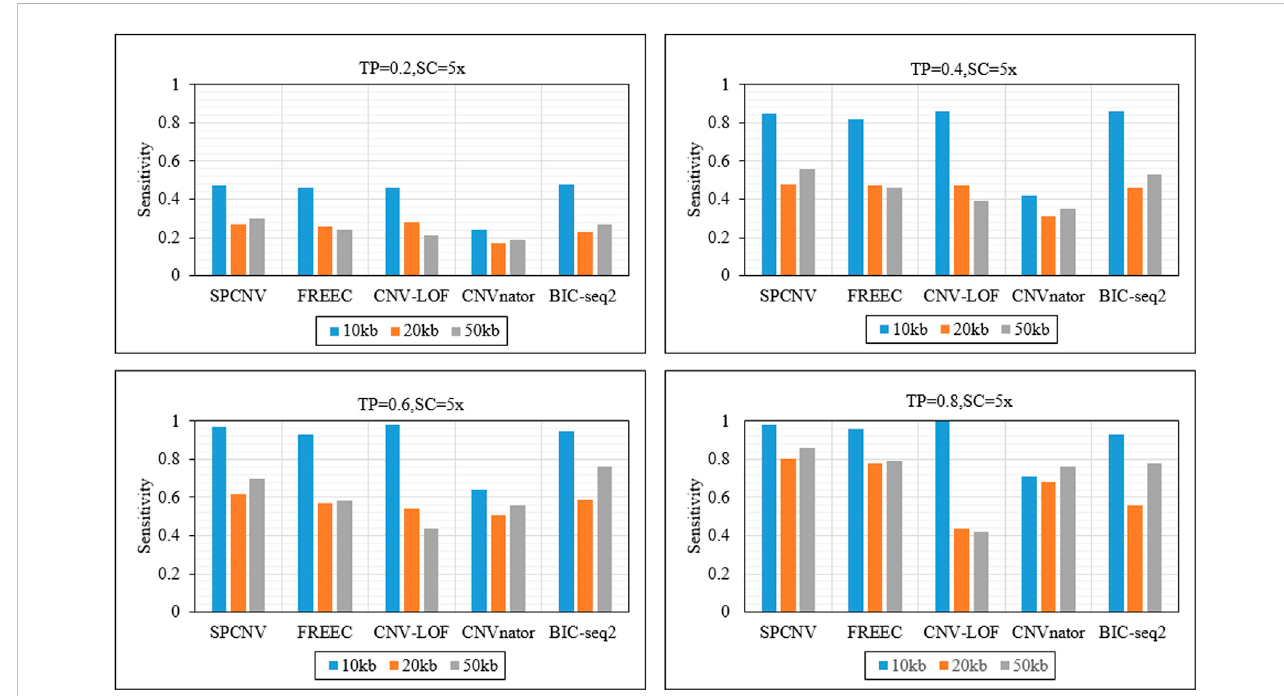
FIGURE 5 Thesensitivityof fi vemethodsatthethreeCNVlengthlevelsunderfoursets ofsimulationcon fi gurations.Theequationsontheleftandrightsidesofthe comma represent the tumor purity (TP) and sequencing coverage (SC),